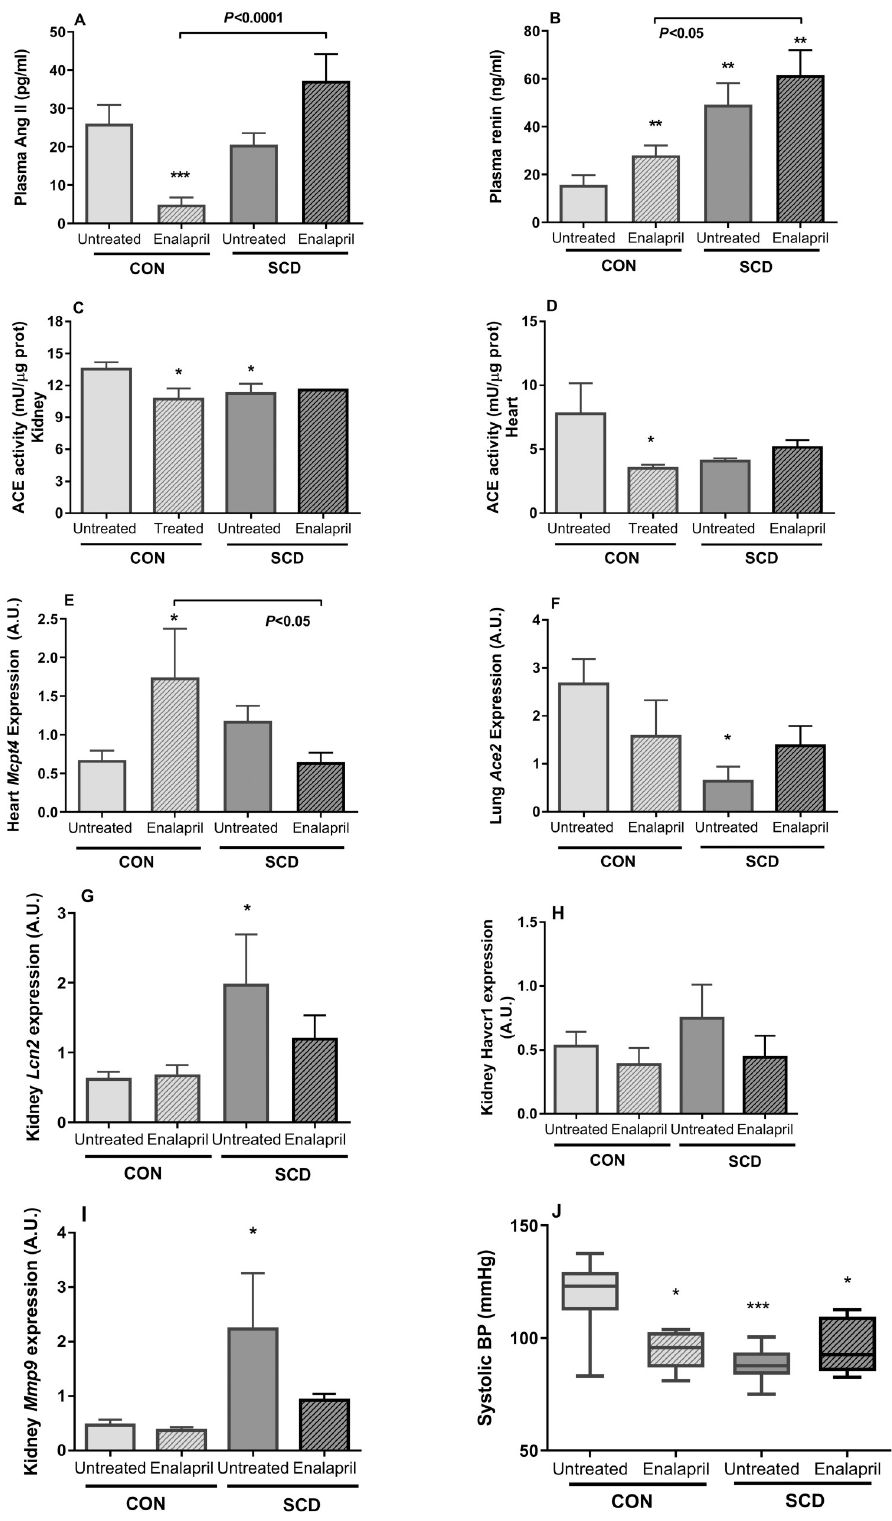
Fig 5. Effects of ACE inhibition upon blood pressure, proteinuria and systemic RAS protein expression and production in SCD mice. Control (CON) and SCD (SCD) mice (5 months old) were treated, or not, for 5 weeks